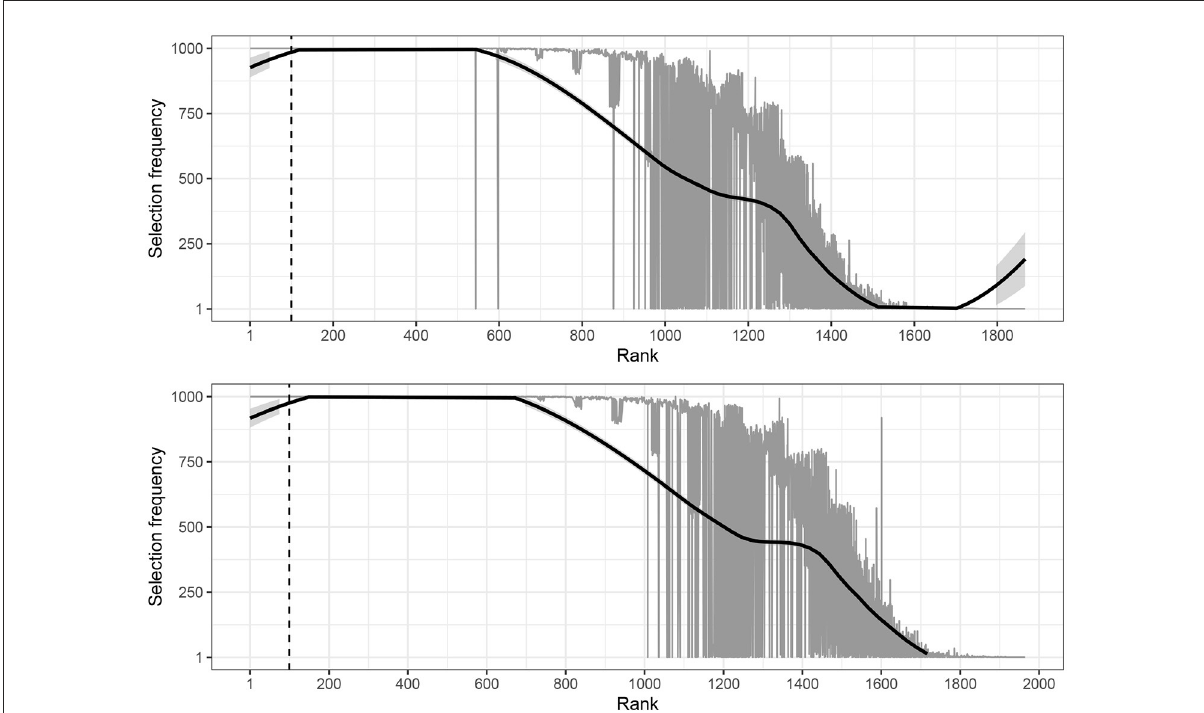
FIGURE3 Visualization of the relationship between the selection frequency and rank of the estimated weights presented separately for news (top) and blogs (bottom) estimated with the TDK. The dashed vertical line indicates the delimiter of the top 100 keyword. The solid black trend line was estimated with